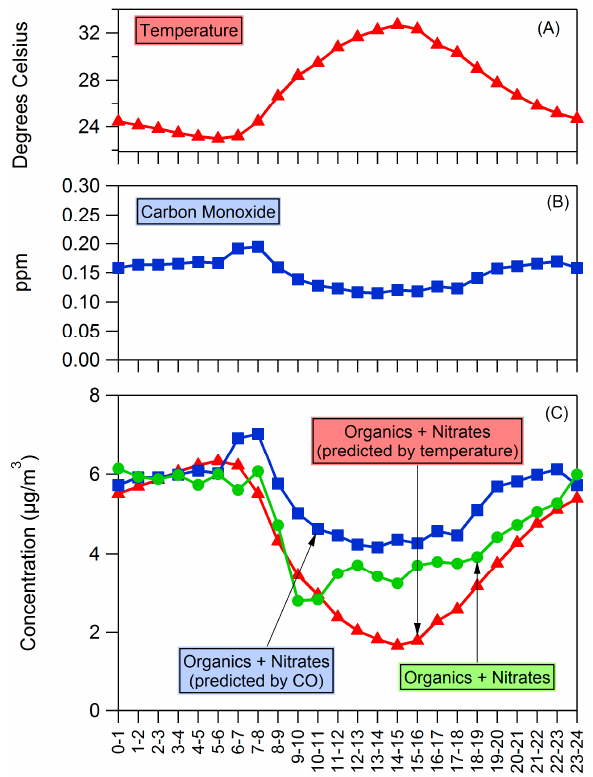
Figure 8. Diurnal profiles of ( A ) temperature and ( B ) carbon monoxide. ( C ) shows the diurnal profile of OA as well as the diurnal profile of OA predicted by temperature and boundary layer height changes. Starting concentrations in predictions are the average of measured concentrations between 0:00 and 6:00.